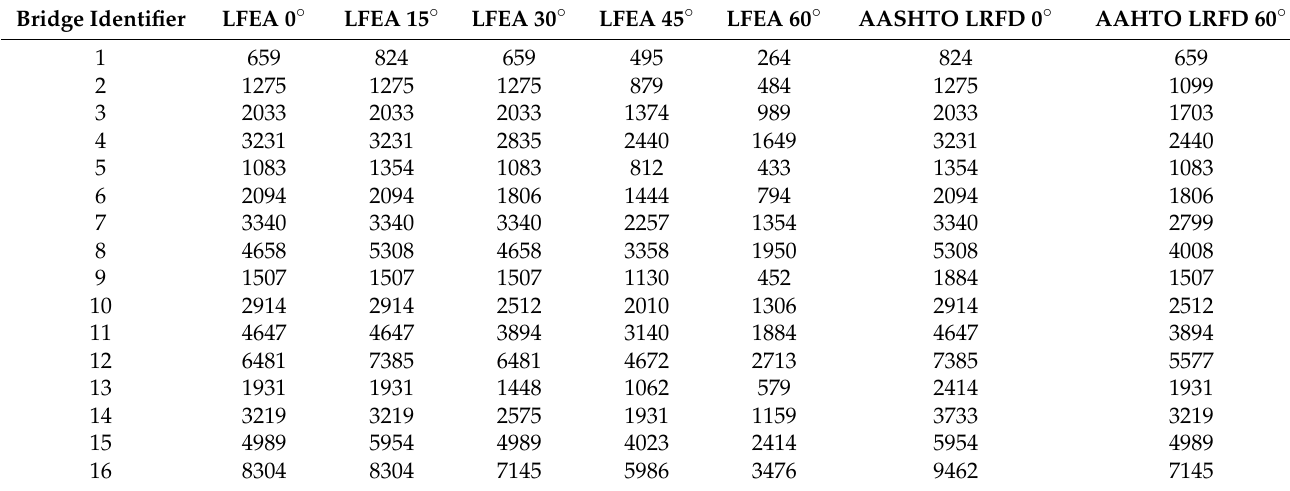
Table 8. Weight (in kg) of steel reinforcement for bending moment—longitudinal reinforcement. Bridge identifiers are explained in Table